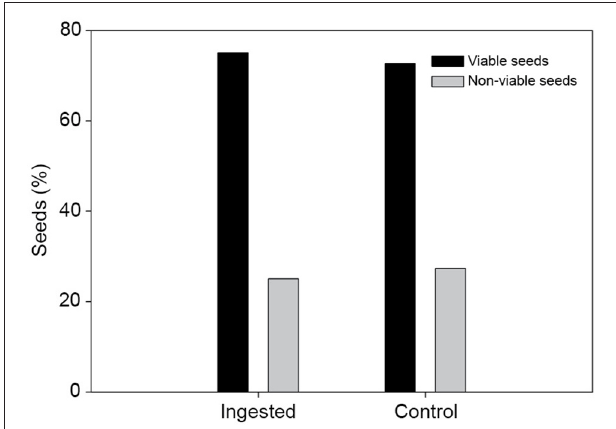
FIGURE 5 | Effect of Columba junoniae gut treatment on Dracaena draco seeds. Ingested and control seeds showed no statistical differences in